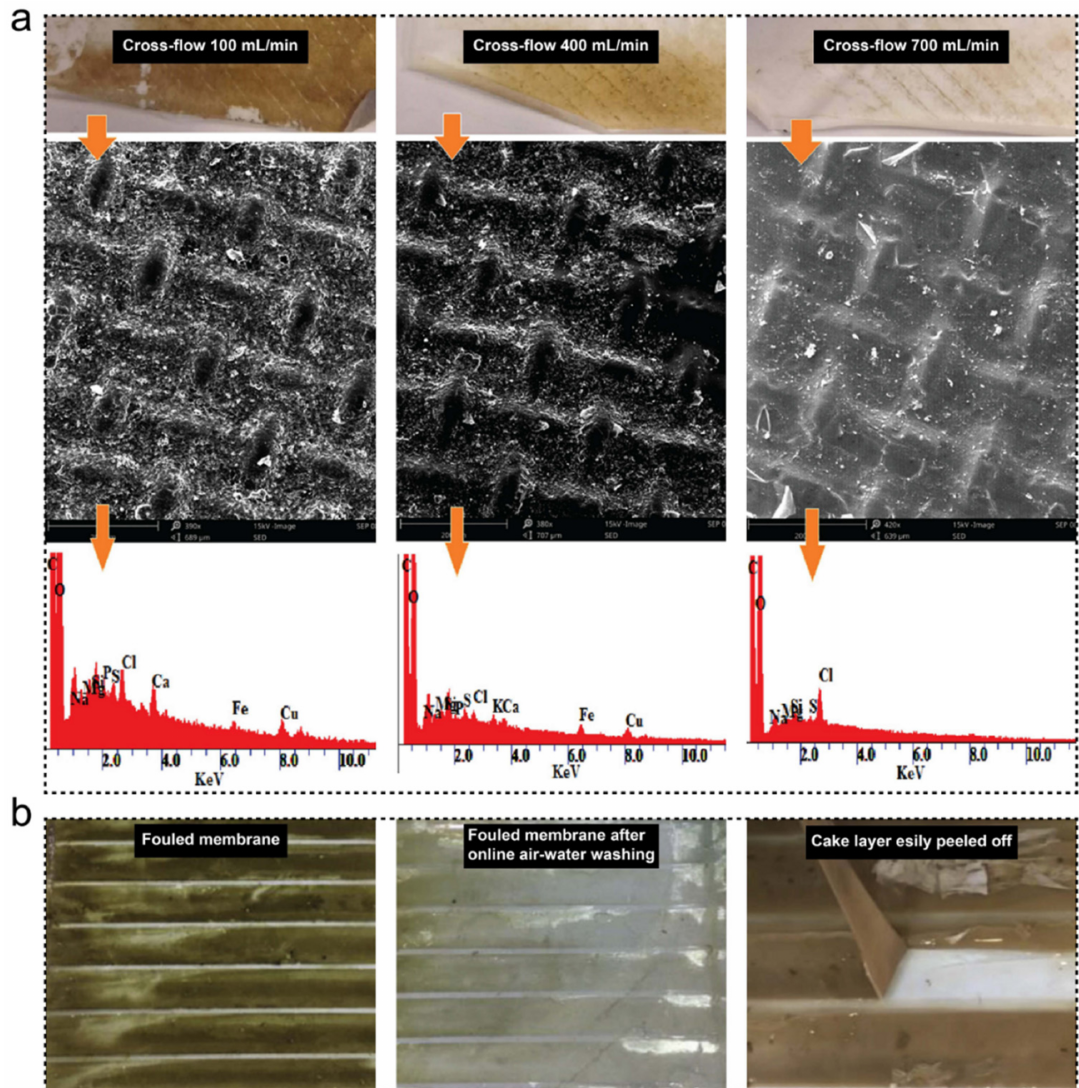
Figure 2. ( a ) Fouling behaviours of CTA-FO membranes with different cross-flow velocities, reprinted with permission from [48], and ( b ) photographs of the fouled membrane ( left ), fouled membrane after online air-water washing ( middle ), and visualisation of the easily peeled-off cake layer, reprinted with permission from